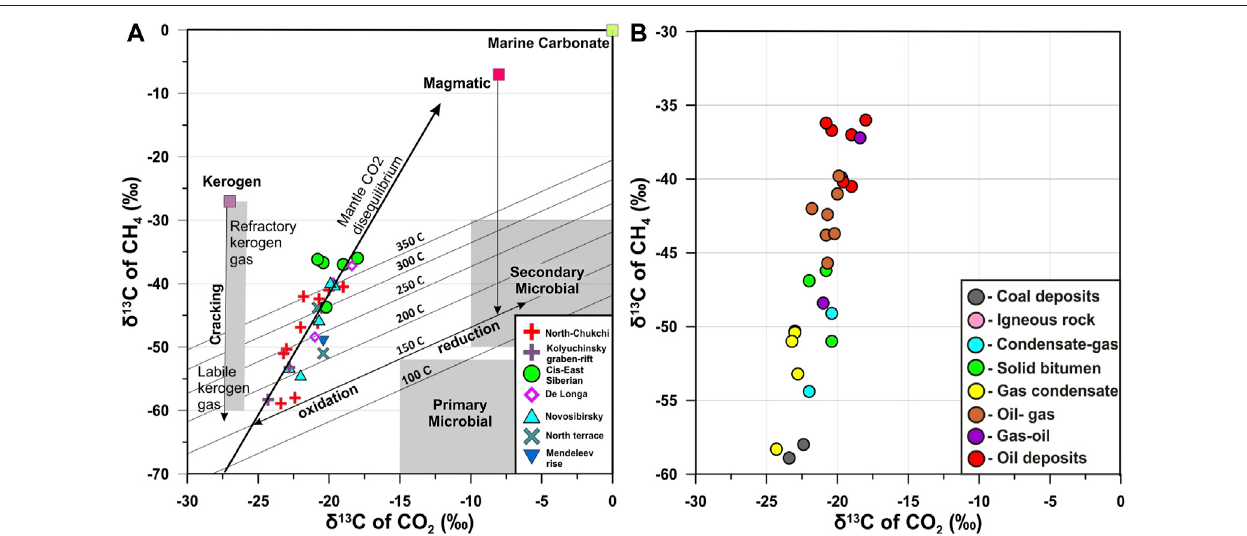
FIGURE 5 | Plot of values of δ 13 C-CH 4 vs. δ 13 C-CO 2 after Giggenbach (1997) (A) . Thin solid lines represent compositions expected for attainment of isotopic equilibrium as a function of temperature. Solid dashed lines correspond to compositions expected for formation of CH 4 and CO 2 from a common C source, such as a kerogen with δ 13 CoftotalCof − 27 ‰ ,ormagmaticCwith δ 13 Cof − 7 ‰ ,asafunctionofthepercentage ofCO 2 inthegasmixtureformed.Plotofvaluesof δ 13 C-CH 4 vs. δ 13 C-CO ’ sgasgeneticgroups (B) :1)coalandgasdeposits,2)igneousrock,3)condensate-gas,4)solidbitumen,5)gascondensate,6)oilgas,7)gas 2 withauthor oil, and 8) oil deposits.